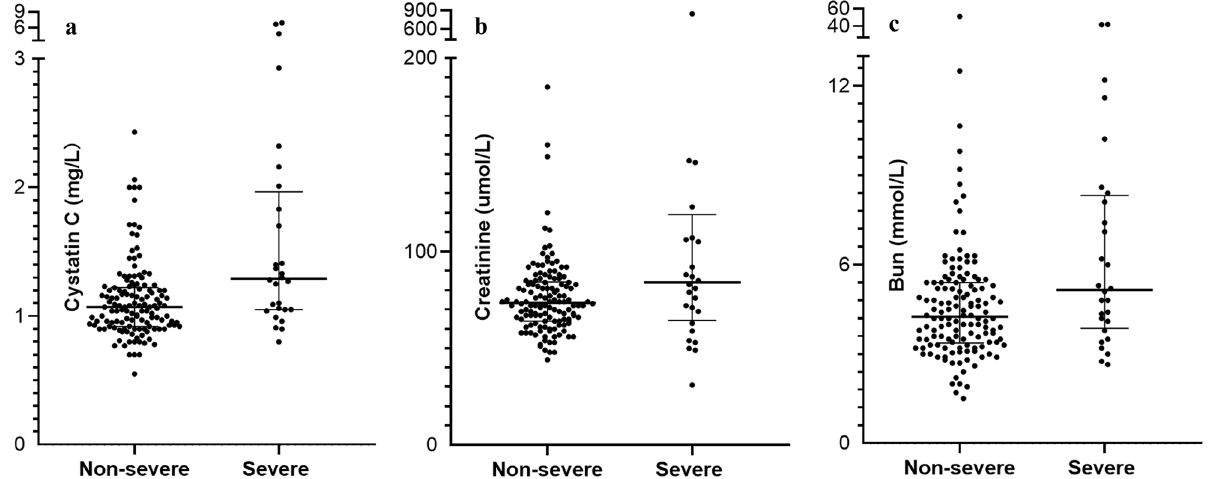
Figure 1. Compariosn of serum levels of cystatin C, creatinine, and Bun in COVID-19 patients. ( a ) Serum level of cystatin C in severe and non-severe COVID-19 patients; ( b ) Serum level of creatinine in severe and non- severe COVID-19 patients; ( c ) Serum level of Bun in severe and non-severe COVID-19 patients; Abbreviations: COVID-19 = coronavirus disease 2019, Bun = blood urea nitrogen, sCr = serum creatinine.